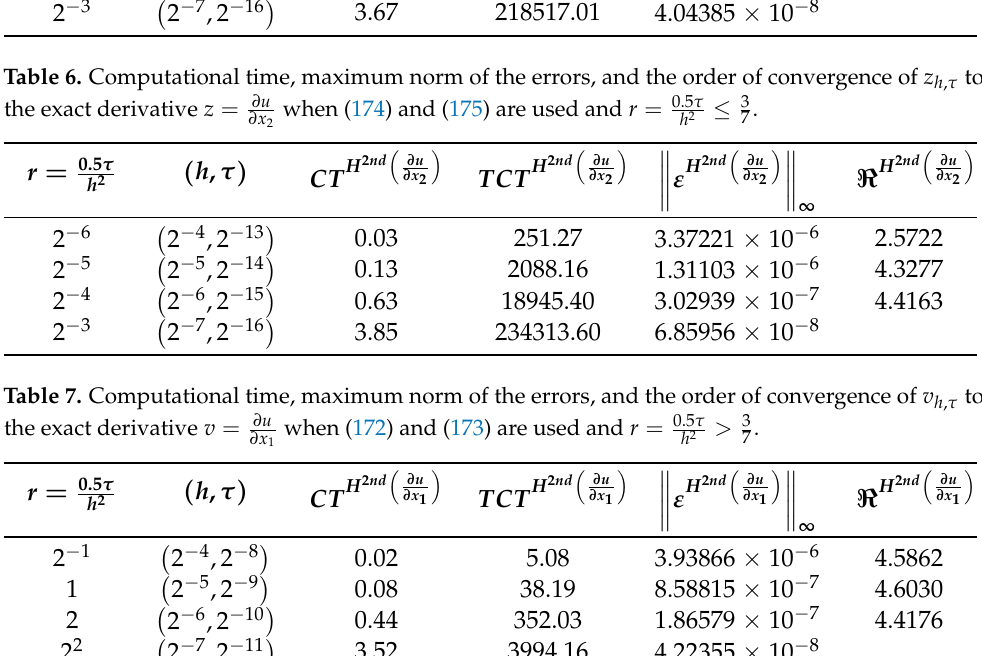
Table 5. Computational time, maximum norm of the errors, and the order of convergence of v h , τ to the exact derivative v = ∂ u when (172) and (173) are used and r = 0.5 τ ∂ x 1 r = 0.5 τ h 2